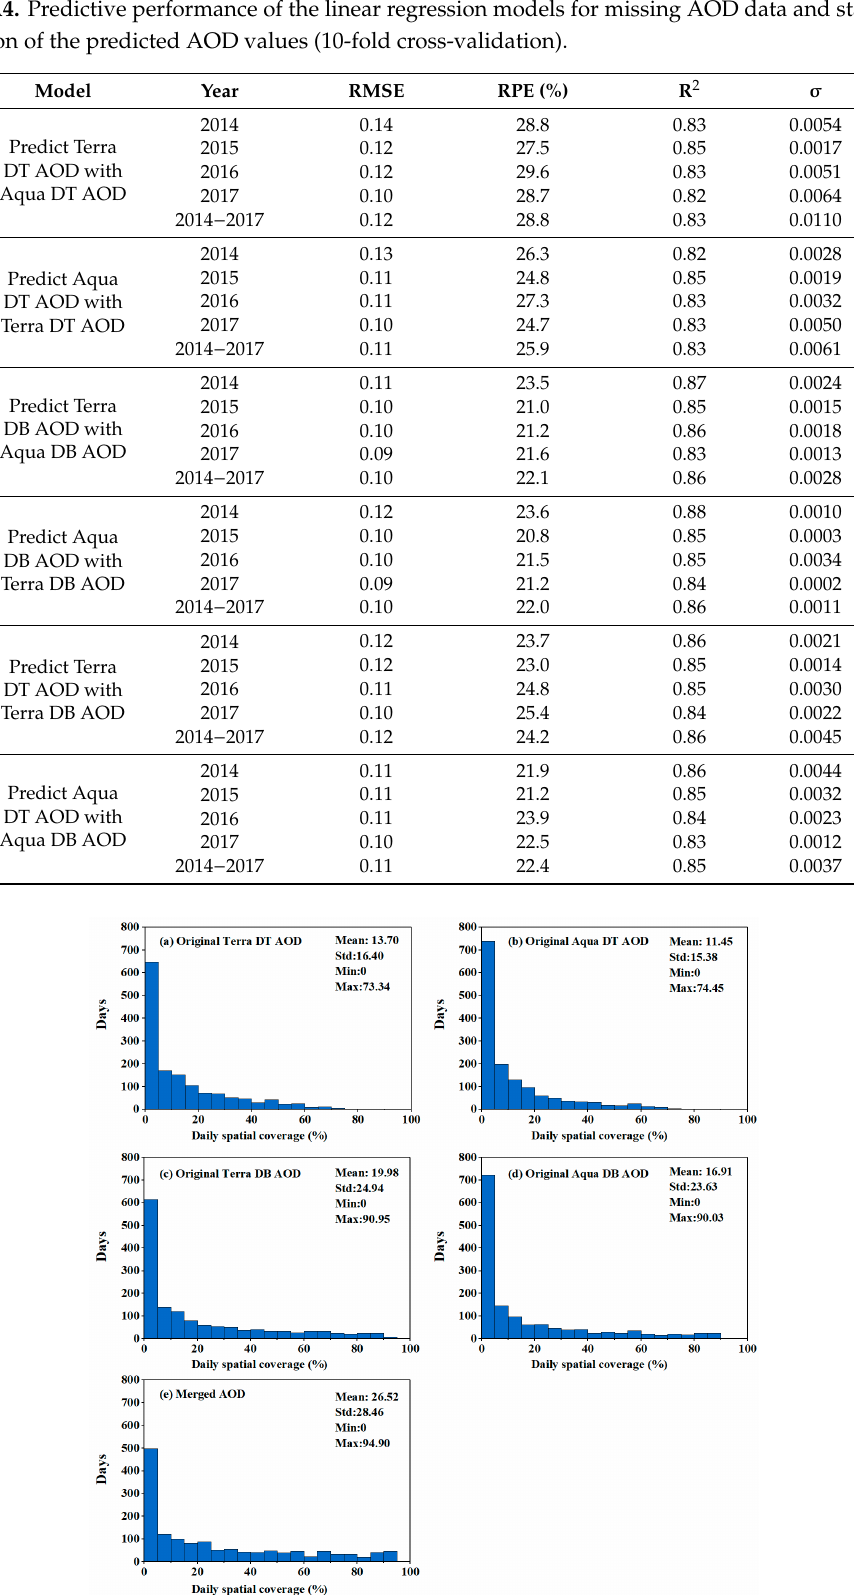
Figure A1. The histograms of the daily spatial coverage of (a) original Terra DT AOD; (b) original Aqua DT AOD; (c) original Terra DB AOD; ( d ) original Aqua DB AOD; and ( e ) merged